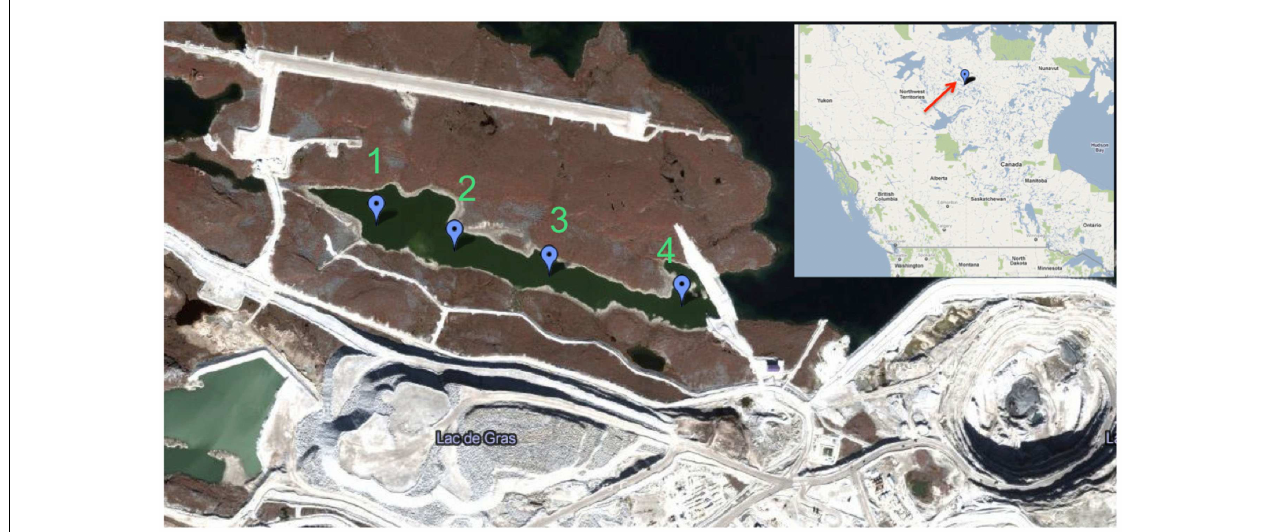
FIGURE 1 | Map of retention pond and location of Diavik Diamond Mines Inc. (courtesy of DDMI) in the NorthwestTerritories, Canada. Water sampling sites 1–4 are indicated by balloons. Only sites 1 and 3 were accessible during ice cover (September 2009–May